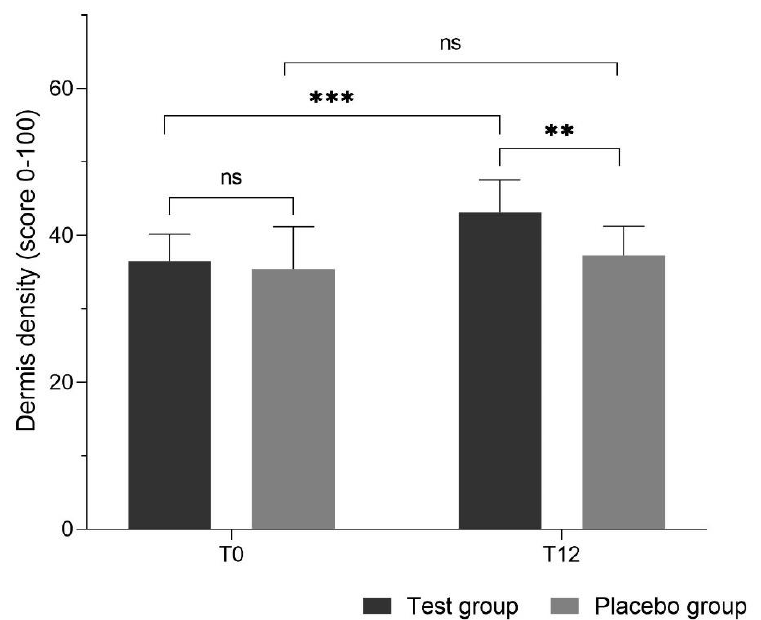
Figure 2. Dermis density before intake (T0) and after 12 weeks of intake of study products (T12). Oral administration of the test product led to increased dermis density after 12 weeks, while in the placebo group there was no significant change over the same period of time. (ns: not significant, ** p < 0.01, *** p < 0.001).